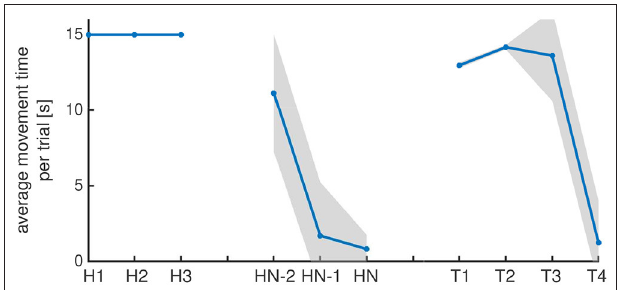
FIGURE 7 | Movement times averaged across simulation runs that were aligned as in the experimental analysis: The first and the last three habituation trials, the test trials in vertical movement direction (T1 and T2) and the test trials in the original movement direction (T3 and T4). The standard deviation across simulation runs due to noise in the fields is shown in